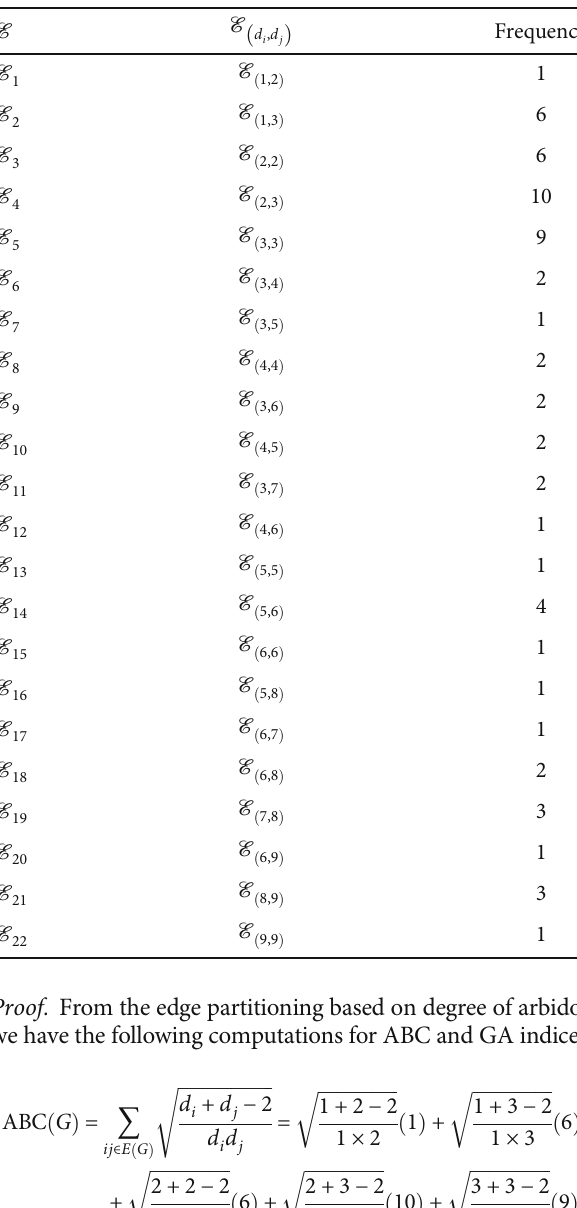
p 2 2 + 2 2 p 3 2 + 5 2 p 4 2 + 5 2 p 5 2 + 7 2 p 6 2 + 7 2